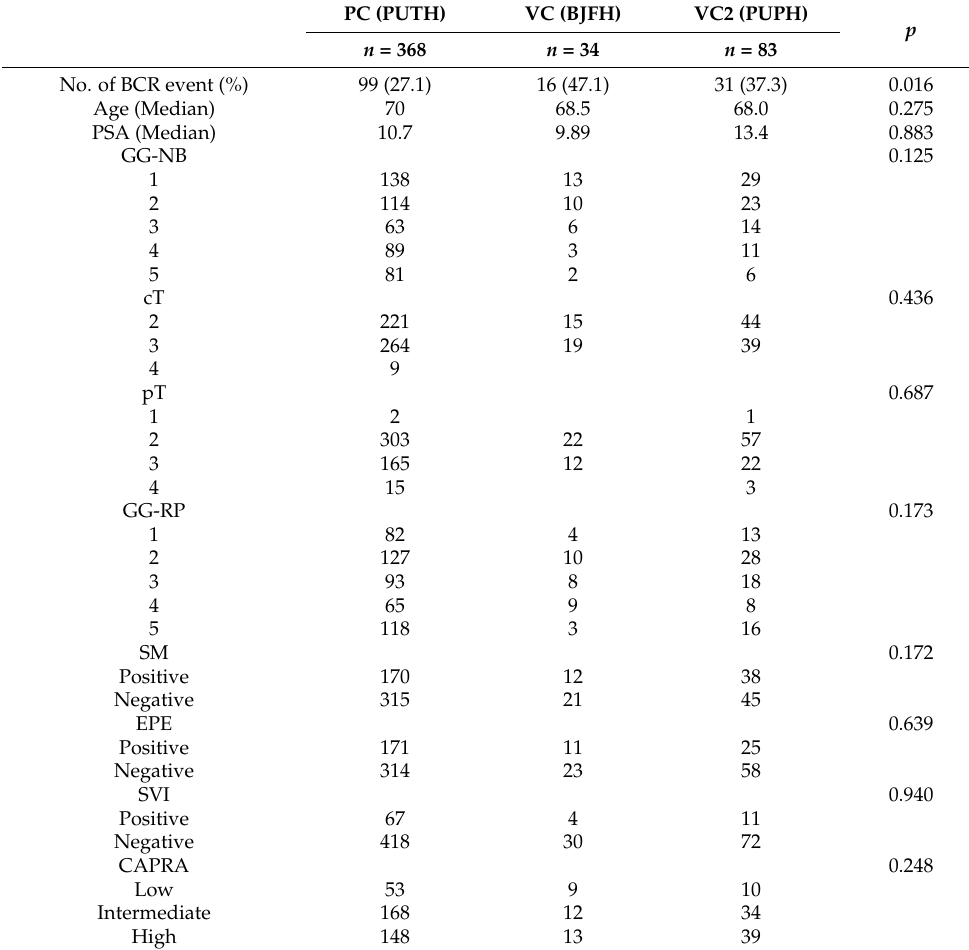
Table 1. Performance of clinical models and deep radiomic models of BCR prediction by univariate cox proportional hazards